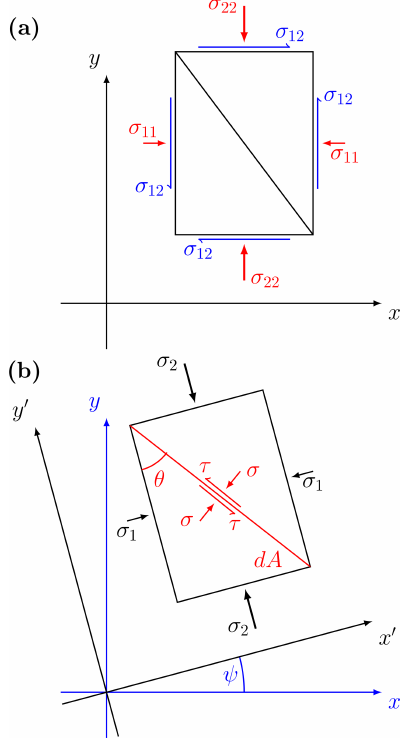
Figure A1. Stress state in physical stress space (a) and in an arbi- trary coordinate system oriented at an angle θ with respect to the principal stress axes (b) . The principal stresses are the eigenvalues of the stress tensor in an arbitrary coordinate system, and the angle ψ is derived from the rotation matrix composed of the two eigenvec- tors. Note that in the study above there is no shear stress ( σ 12 = 0, so principal axes and physical axes are aligned ( ψ = 0).